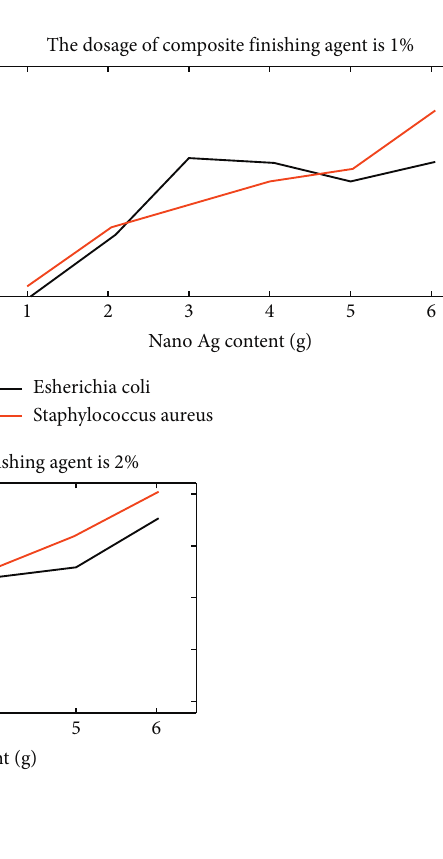
Figure 3: Different amounts of composite finishing